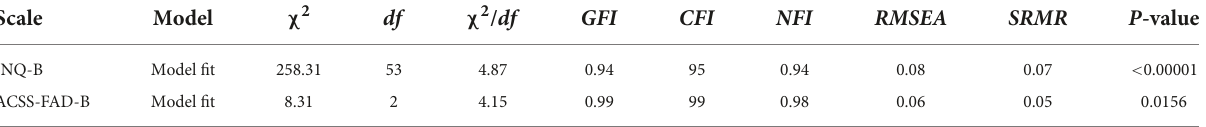
TABLE 4 Fit indices of confirmatory factor analysis for INQ-B and ACSS-FAD-B ( n = 1,207).